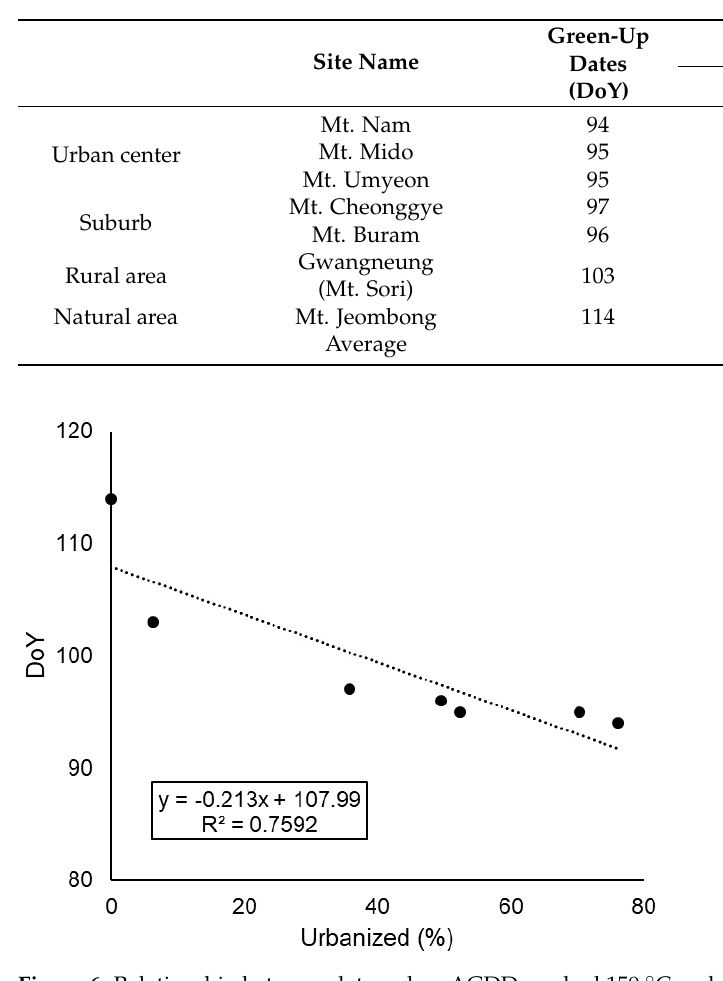
Table 5. Green-up dates estimated by AGDD and AGDD values for green-up dates derived from ExG and EVI.